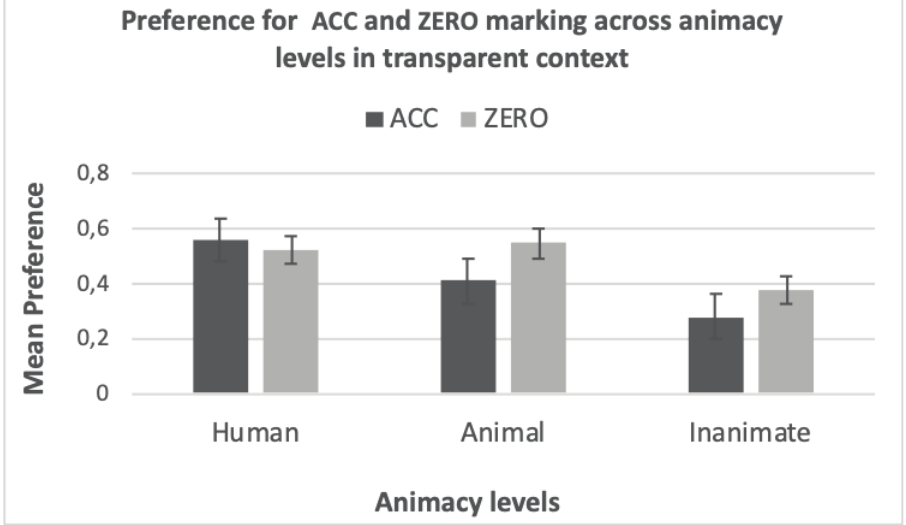
Figure 2. Preference for sentences with indefinite direct objects belonging to different animacy levels with zero and overt DOM marking used in transparent context. Error bars represent +/- 2 standard errors